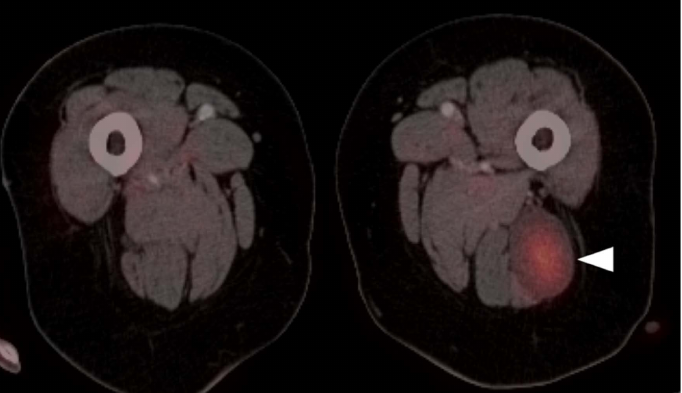
Figure 28. Low-grade malignant nerve sheath tumor. Features that suggested that the lesion (white arrowhead) could be malignant on this axial FDG PET-CT image of the thighs was an SUVmax of 6.8 (in the indeterminate range), an enlarging mass and sensory symptoms (described as a “tingling, burning sensation”).